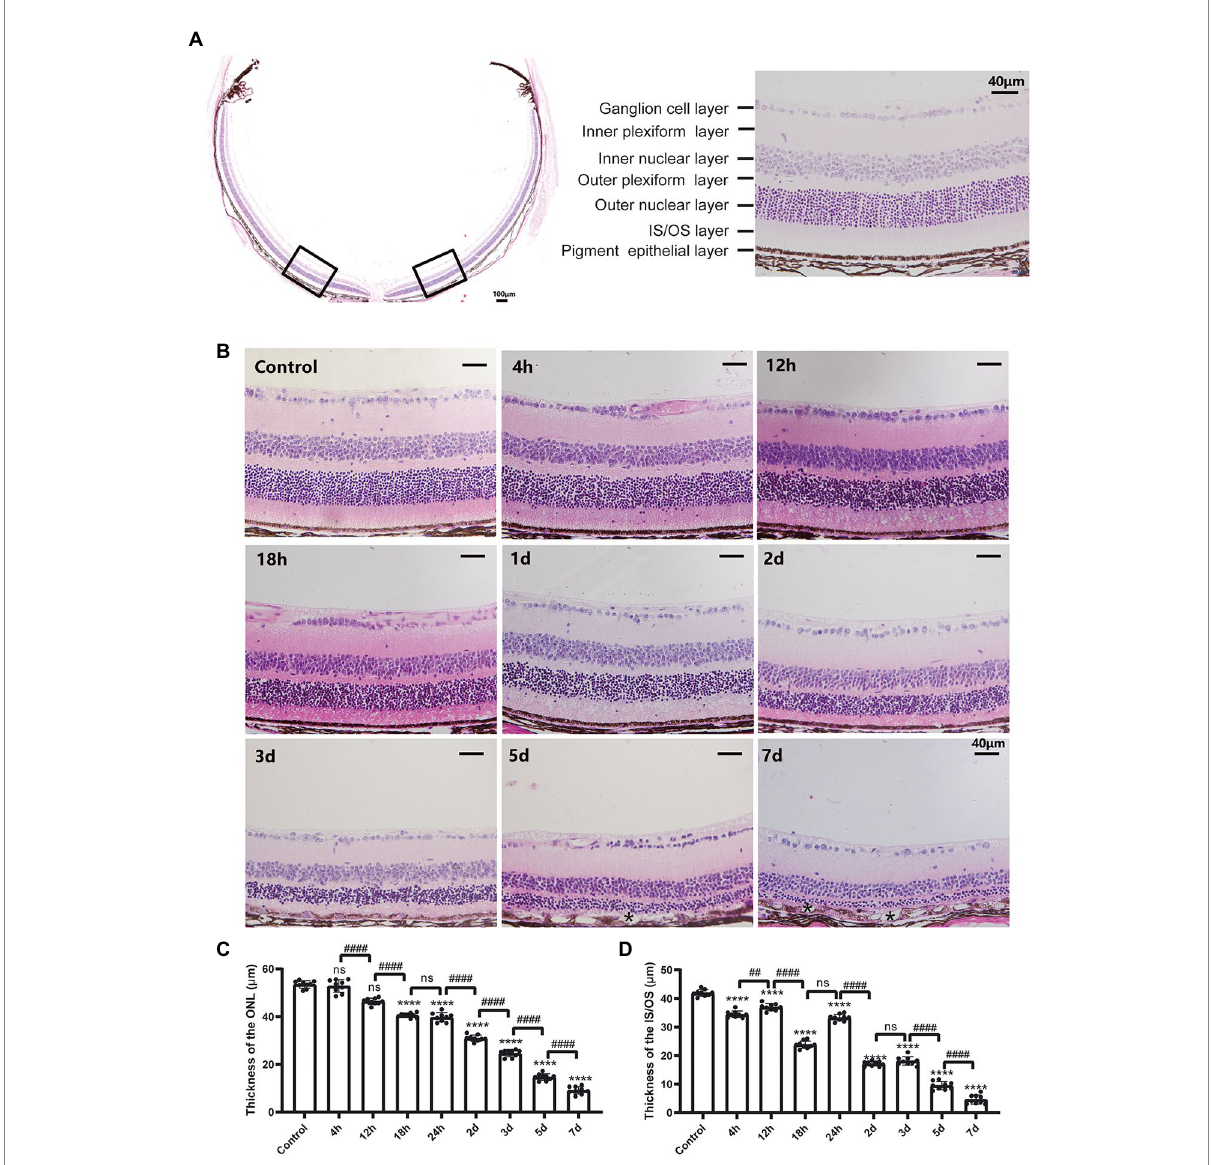
FIGURE 1 Morphological changes of the retina after MMS treatment with time. (A) The representative image of the whole cross-section profile of normal mouse retina (20×, scale bar, 100 μ m; 40×, scale bar = 40 μ m). (B) Retinal morphological changes of different MMS treatment time points. Both of the ONL and IS/OS layers were thinner with time. At 5 and 7 days post MMS injection, * indicates the RPE depigmentation and vacuoles formation (40×, scale bar = 40 μ m). (C) The thickness of the ONL after MMS treatment with time. (D) The thickness of the IS/OS after MMS treatment with time. Data were expressed as mean ± SD, n = 3/group. One-way ANOVA followed by Tukey’s post hoc test, **** p < 0.0001 for differences compared to controls, ### p < 0.001, #### p < 0.0001 for differences compared to previous time point